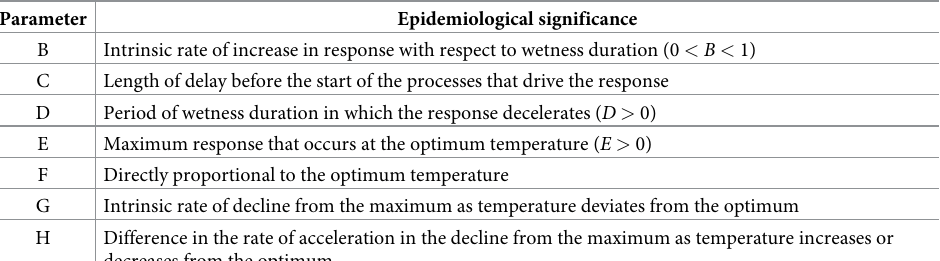
Table 1. Summary of epidemiological significance of parameters in the model proposed by Duthie [33], Eqs 1, 2, and 3, which describes the response of foliar parasites to the combined effects of temperature and duration of